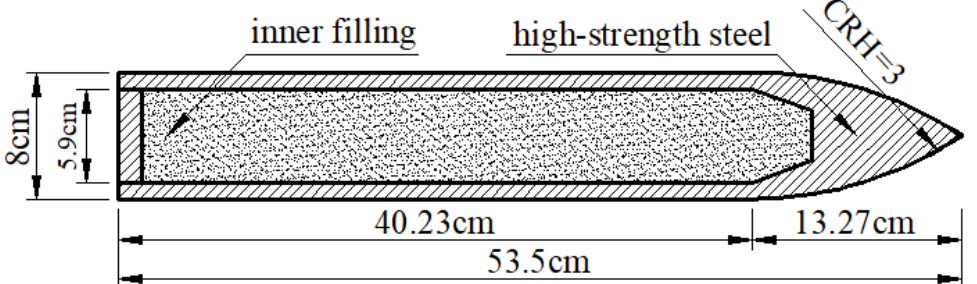
Figure 4. Ogive -nose projectile.